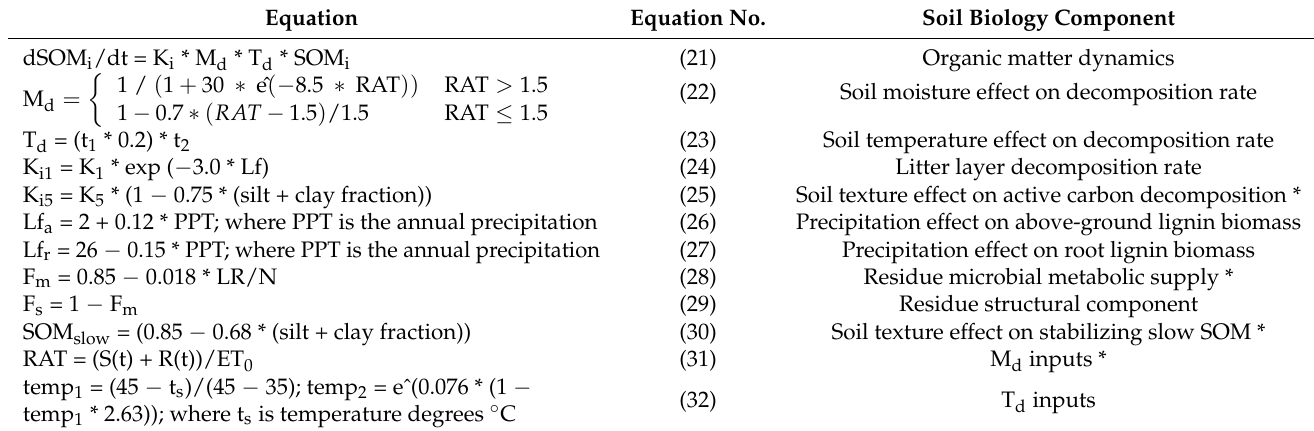
Table 2. Summary list of model biological equations constituting the core structure of the agroecosystem model, developed from [93–95]. * Descriptions indicate operationalized feedback linkage with other model components. Equation Equation